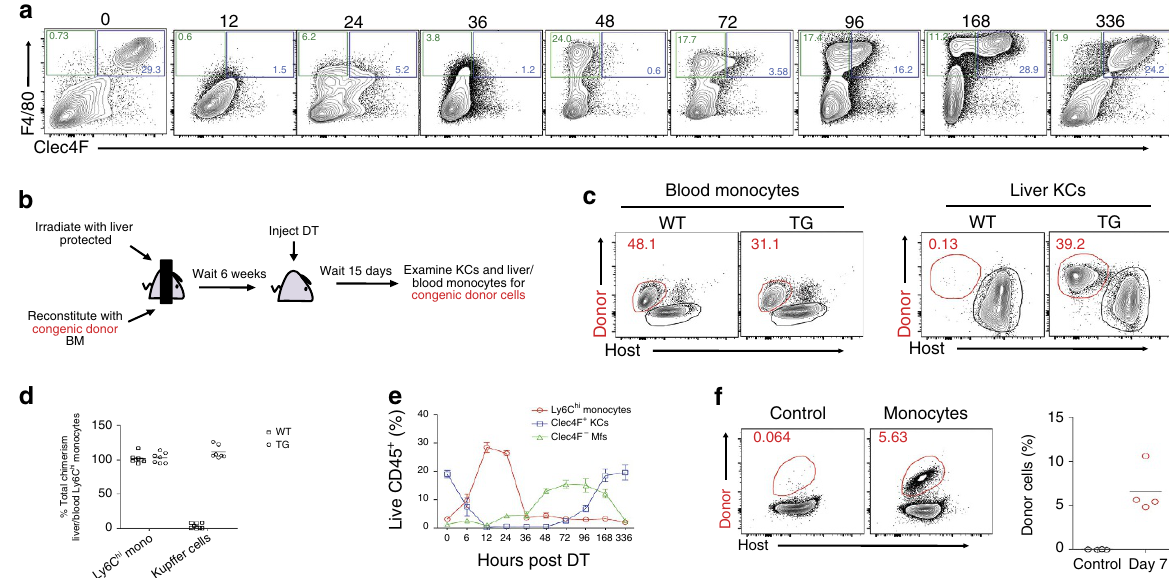
Figure 3 | Depleted em-KCs are rapidly replaced by mo-KCs. ( a ) Expression of Clec4F and F4/80 at indicated time-points (h) post administration of DT. FACS-plots are pre-gated on Live CD45 þ SiglecF (cid:2) Ly6G (cid:2) Ly6C (cid:2) single cells. Data are representative of three experiments. ( b ) Schematic for generation of shielded chimeras to test origin of repopulating Clec4F þ m f s. ( c , d ) KC-DTR (TG) or WT littermate control (WT) shielded chimeras were administered DT and blood Ly6C hi monocytes (live CD45 þ CD11b þ Ly6G (cid:2) Ly6C hi ) and liver Clec4F þ m f s (live CD45 þ Ly6C (cid:2) Ly6G (cid:2) SiglecF (cid:2) F4/80 þ Clec4F þ ) were examined for the proportion of congenic donor BM-derived cells. Percentage of total chimerism amongst liver Ly6C hi monocytes and Clec4F þ KCs is shown. Chimerism amongst blood Ly6C hi monocytes was set at 100%. Data are pooled from three experiments. n ¼ 8 (WT) or 7 (Tg). ( e ) Proportion of Ly6C hi monocytes, Clec4F þ KCs and Clec4F (cid:2) m f s in the liver as a percentage of live CD45 þ cells at various time-points post DTadministration. Data are pooled from three experiments. n =18 (0h), 6 (6, 36h), 10 (12, 96h), 8 (24, 48, 72h), 12 (168h) or 7 (336h). Error bars represent s.e.m. ( f ) 8 (cid:3) 10 5 –10 (cid:3) 10 5 BM Ly6C hi monocytes (live CD45 þ CD11b þ Ly6G (cid:2) Ly6C hi CD115 þ ) from WT congenic mice were transferred into DT-administered KC-DTRxCCR2 (cid:2) / (cid:2) recipients and 7 days later, live CD45 þ Clec4F þ F4/80 þ CD11b int KCs in the liver were examined for the presence of congenic donor cells. Data are pooled from two experiments. n ¼ 4 per